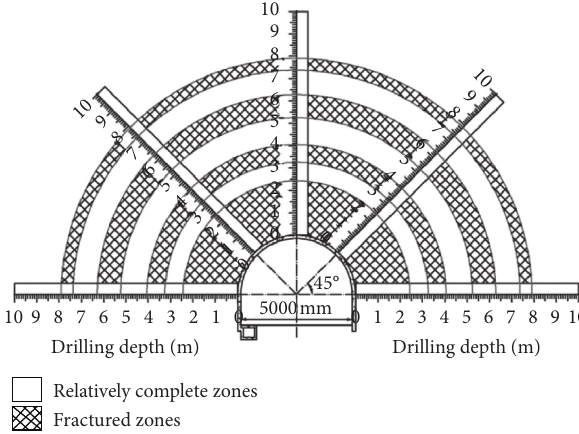
Figure 2: Distribution of cracked zones in Huainan mine of China.